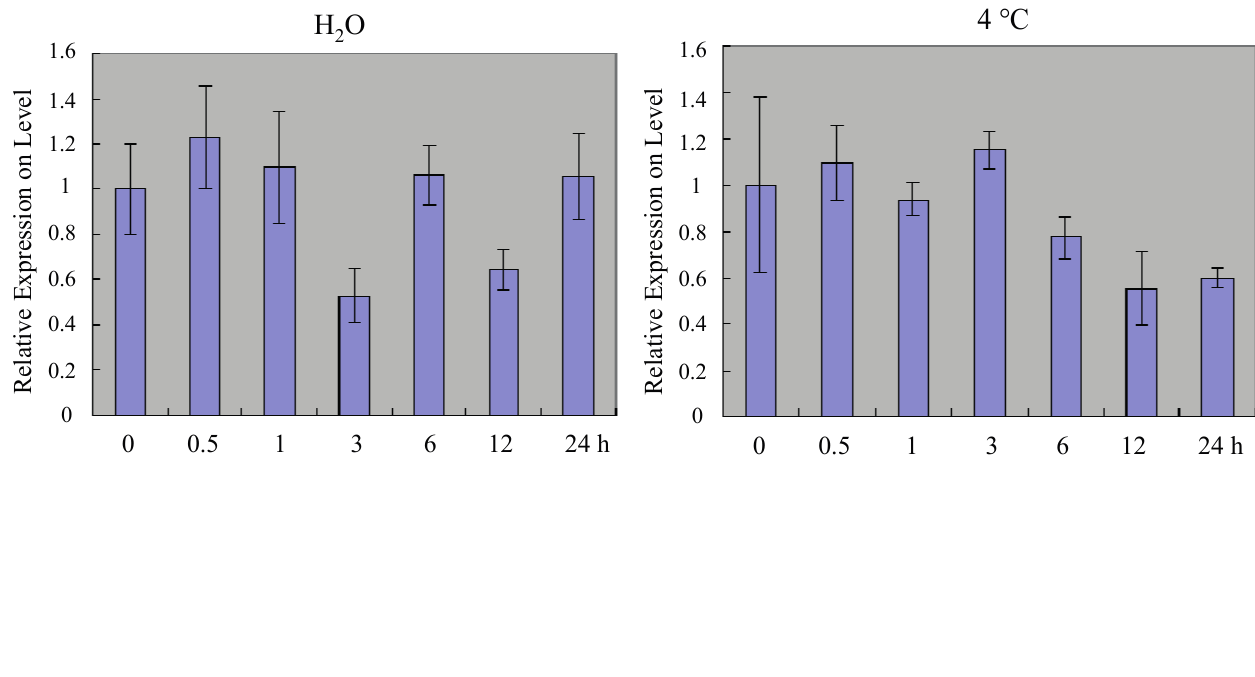
Figure 2. Expression profiles of ZmSOC1. ( A ) ZmSOC1 expression under stress conditions. ZmSOC1 expression was analyzed using qRT-PCR in Z31 leaves under different stress treatments ( i.e. , NaCl (250 mM), PEG6000 (20%), Abscisic Acid (ABA, 100 µM), Salicylic acid (SA, 100 µM), 4 °C, and H 2 O without nutrients) for different period of time (0, 0.5, 1, 3, 6, 12 and 24 h); ( B ) ZmSOC1 expression levels in maize tissues. The standardized data from the GeneChip of maize were used for the expression analysis; the data of eight tissues were extracted from root, stem, leaf, shoot apex, filament, ear, embryo and the endosperm